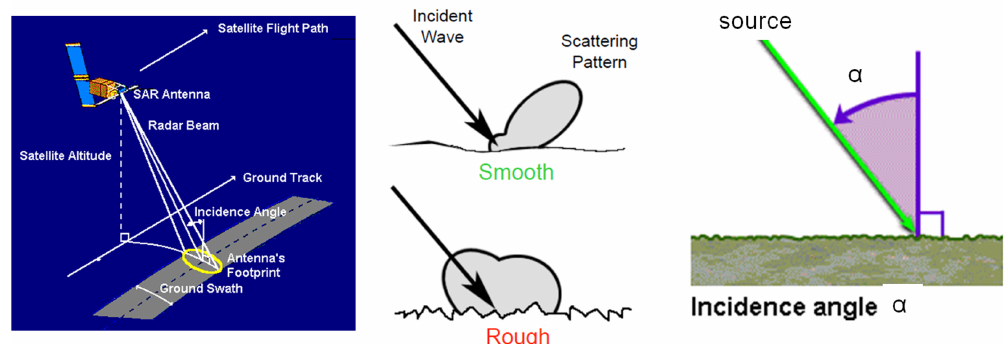
Fig. 1. The backscatter is the portion of the outgoing satellite radar signal, usually looking sideways (left panel) in different incidence angles α (right panel) is highly depending on the backscatter characteristics of the subsurface (middle panel). Adapted from ESA (2012).